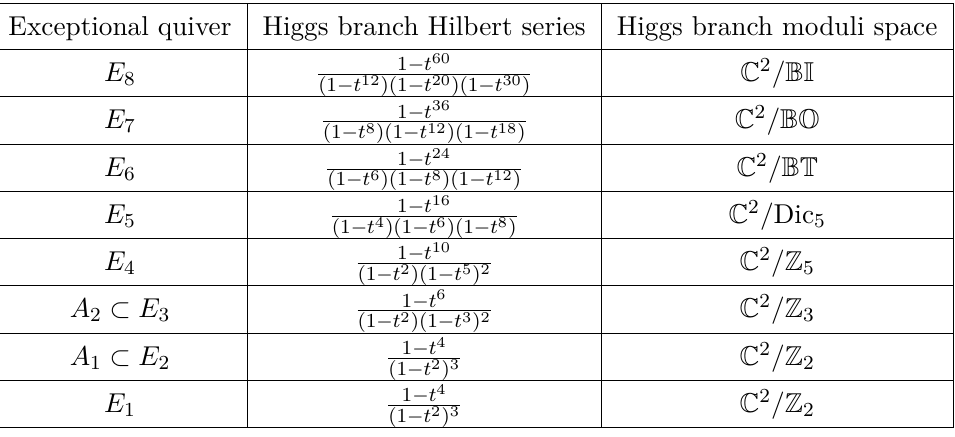
Table 14. We take the unitary-orthosymplectic quivers in this section and computed their Higgs branch Hilbert series. BI is the binary icosahedral group, BO is the binary octahedral group, BT is the binary tetrahedral group and Dic 5 is the binary dihedral